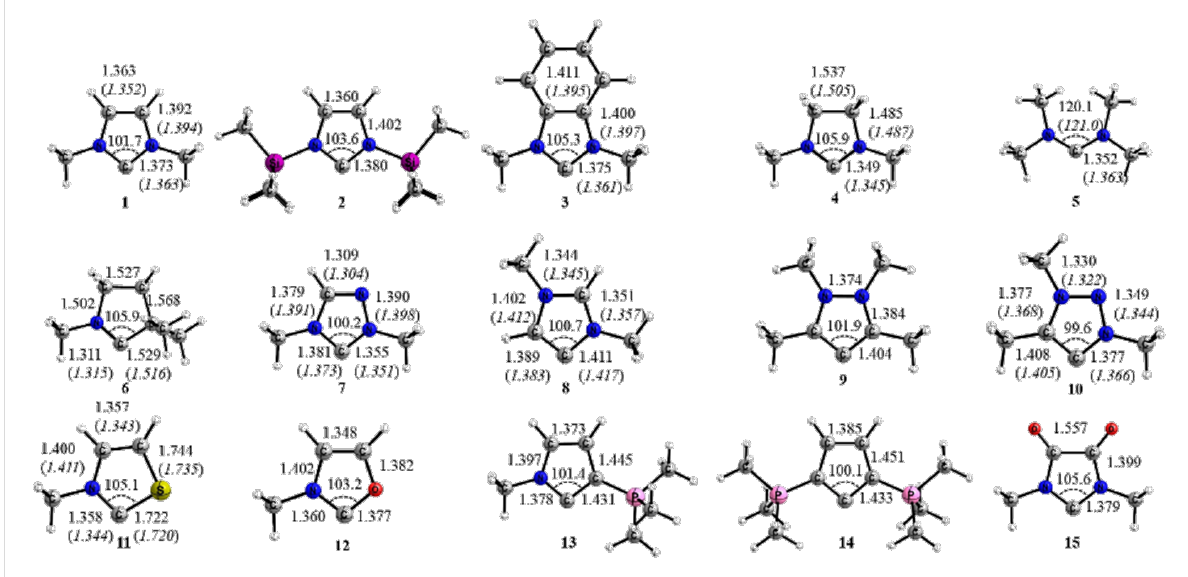
Figure 1: Optimized geometries of carbenes 1–15 at the BP86/def2-TZVPP level of theory. Bond lengths and angles are given in [Å] and [°]. Experi- mental values are given in parentheses: 1 (Ref. [31]); 3 (Ref. [99]); 4 (Ref. [100]); 5 (Ref. [101]); 6 (Ref. [56]); 7 (Ref. [102]); 8 (Ref. [46]); 10 (Ref. [47]); 11 (Ref.